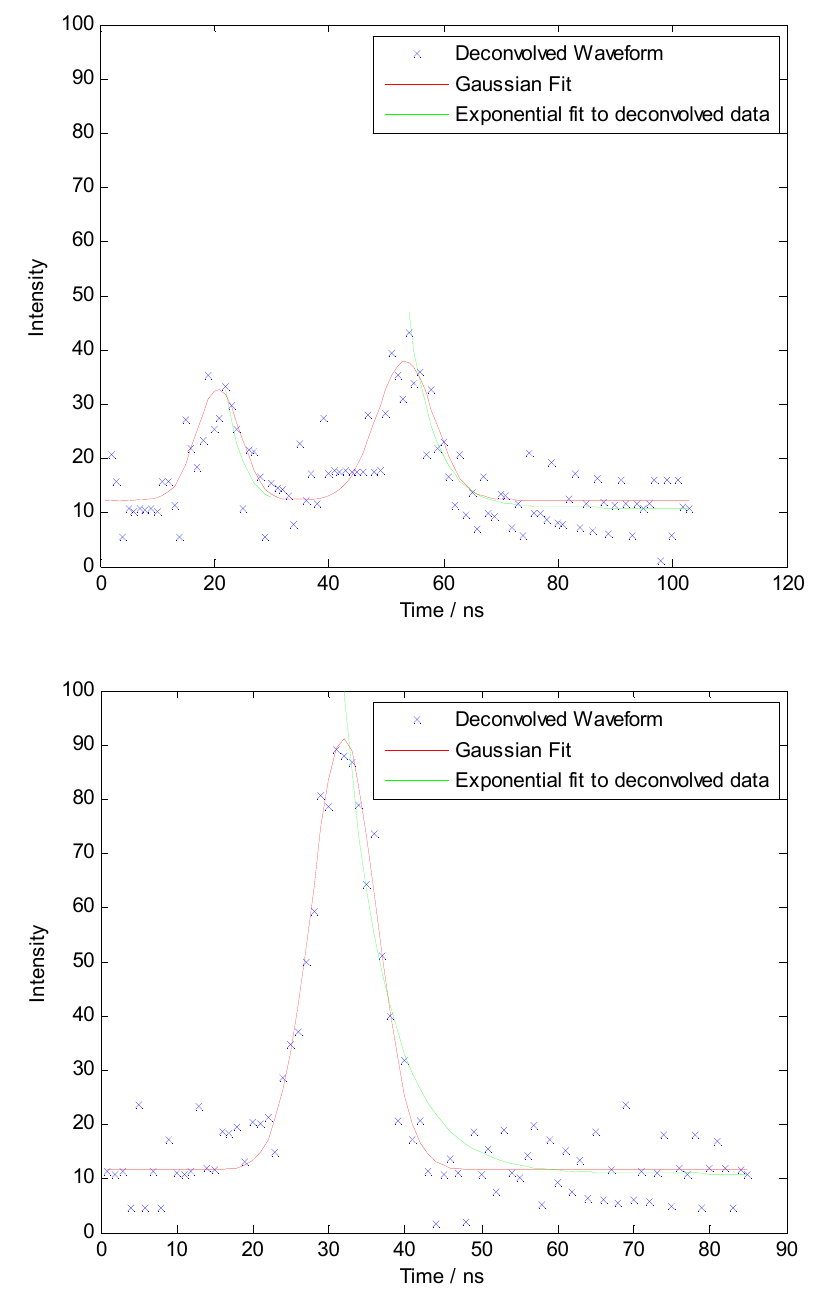
Figure 4. Deconvolved LiDAR data (blue) with multiple Gaussian fitting (red, 1 on the left, two on the right), and decay rates of each peak estimated